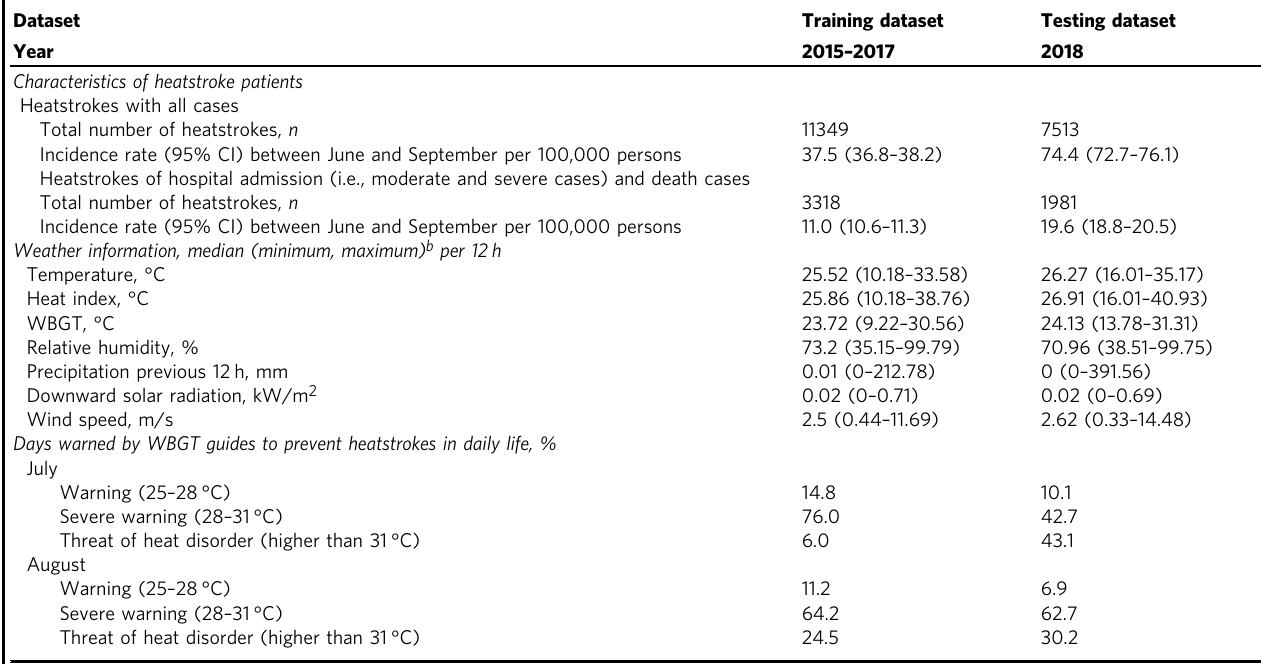
Table 1 Characteristics of present datasets in 16 Japanese cities a between June and September from 2015 to 2018.